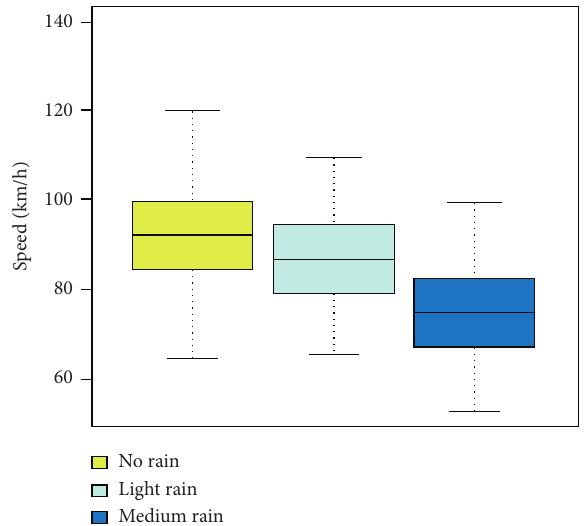
Figure 1: Distribution box diagram of vehicle speed in various rainfall